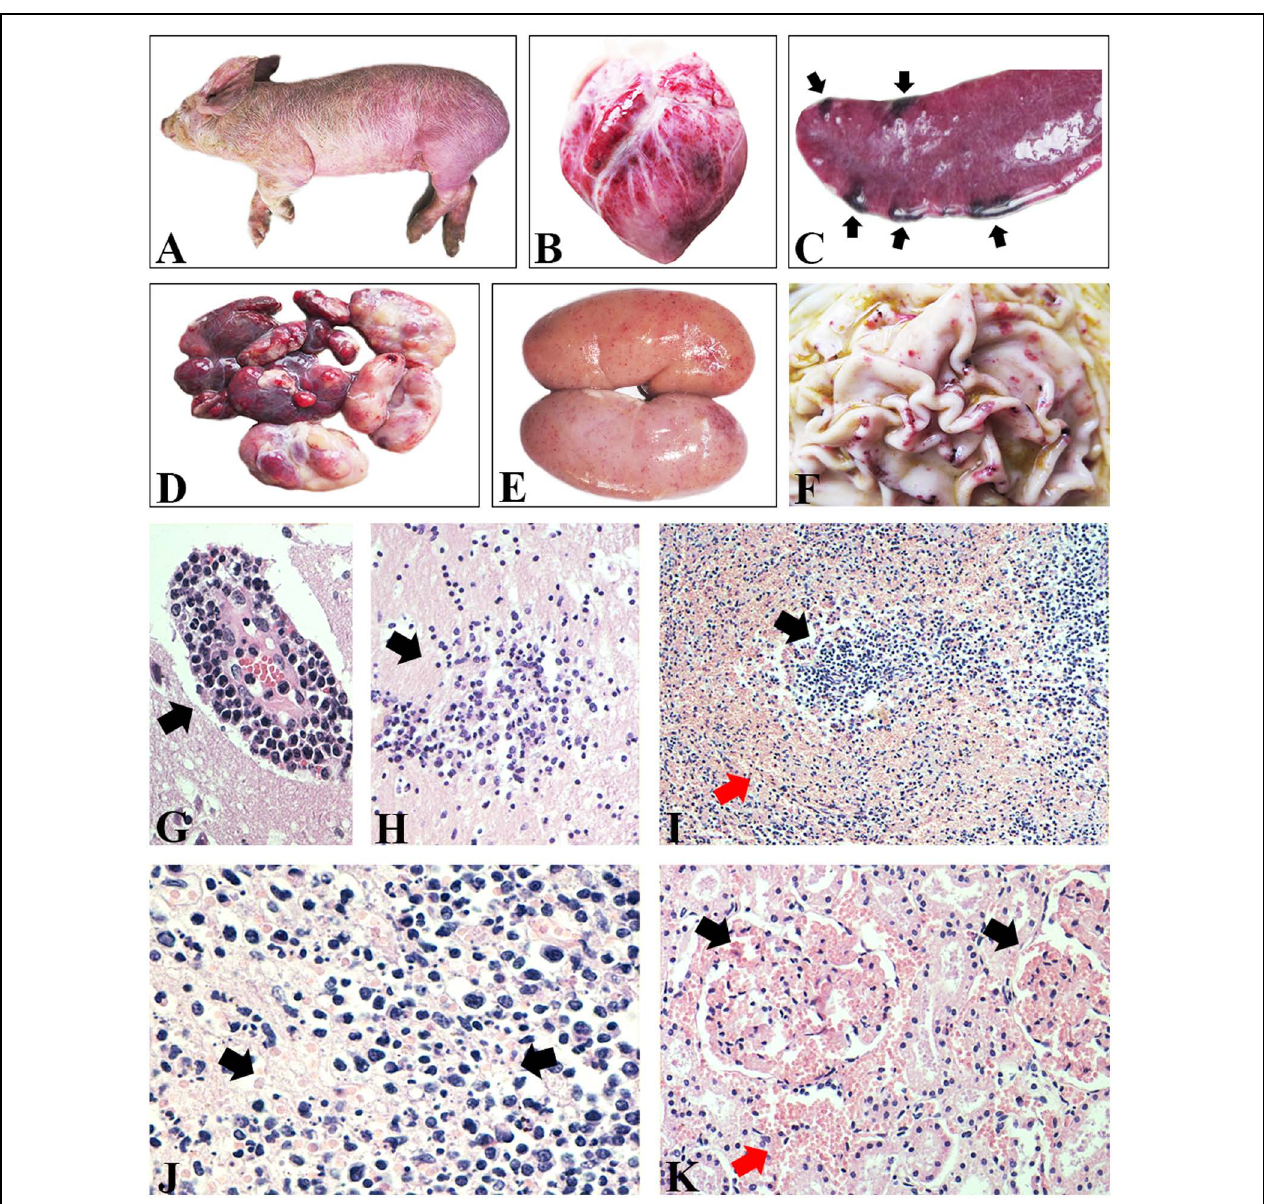
FIGURE 1 | Gross and histological lesions of CSF-suspected pigs. (A) Diffuse hemorrhage of skin. (B) Epicardium hemorrhage. (C) Infarcts scattered on the edge of spleen. (D) Lymph nodes were hemorrhagic and turgid. (E) Renal cortex was densely covered with petechial hemorrhages. (F) Hemorrhagic spots and ulcer on the surface of gastric mucosa. (G) Lymphocyte infiltration around the small blood vessels in brain. H&E stain, × 400. (H) Proliferation of glial cells in brain. H&E stain, × 200. (I) Histological structure of spleen was disordered and characterized by necrotic lymphocytes and hemorrhage. H&E stain, × 100. (J) Lymphoid nodules showed necrotic lymphocytes and hyperplastic reticular cells and hemorrhage. H&E stain, × 400. (K) The glomerulus and mesenchyme were hemorrhagic. H&E stain, ×